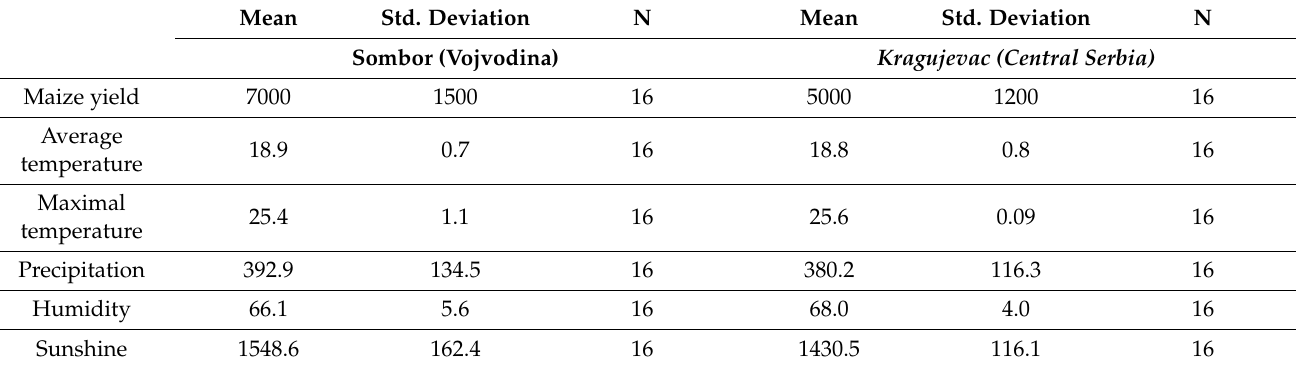
Table 1. Table 1. Descriptive analysis of the space of the Republic of Serbia for the time period 2005–2020. Mean Std. Deviation N Mean Std.